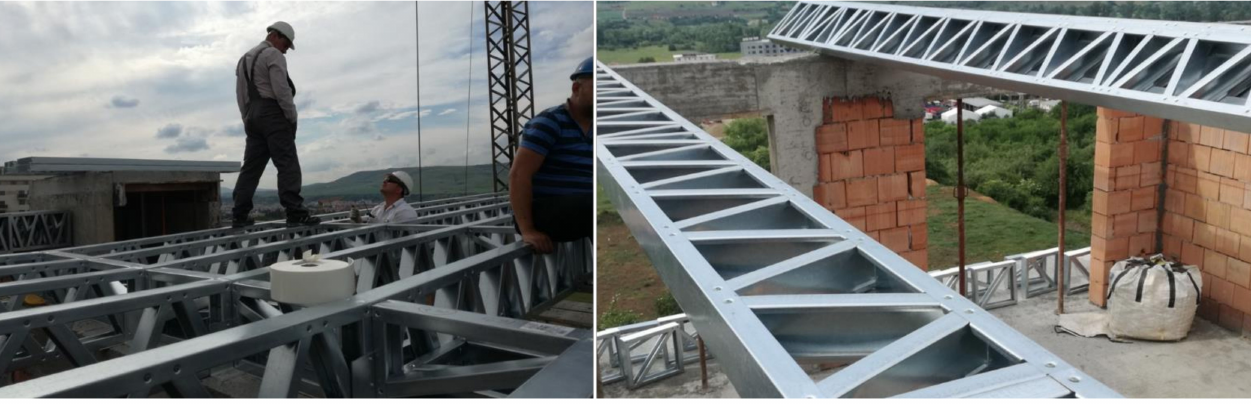
Figure 2. Example of a floor system for a roof made of truss beams with thin-walled steel profiles Cluj-Napoca, Romania 2019 (authors’